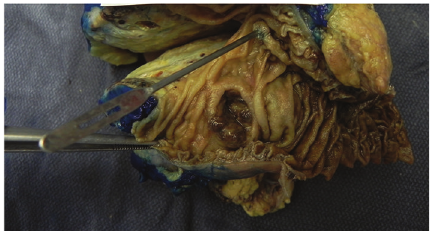
Figure 4: Luminal view of duodenum with invasion of the second